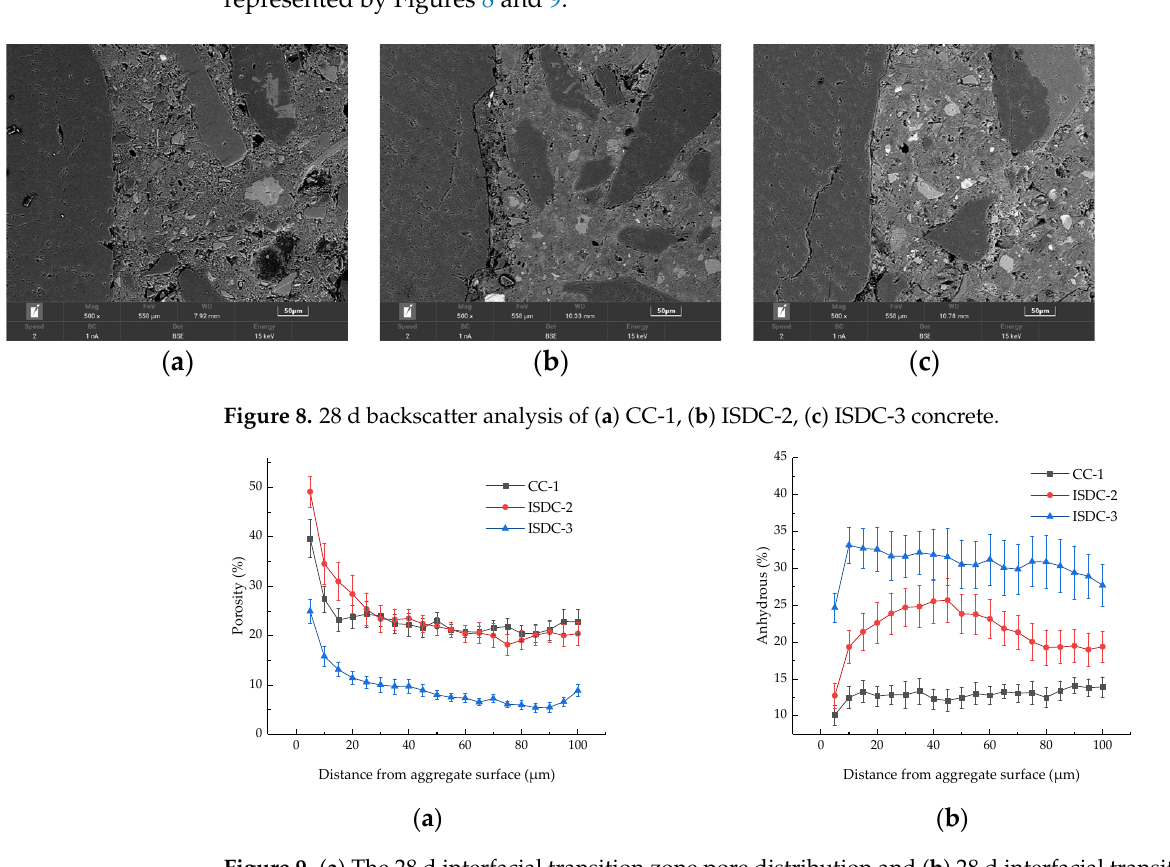
Figure 9. ( a ) The 28 d interfacial transition zone pore distribution and ( b ) 28 d interfacial transition zone non ‐ hydration distribution of ISD ‐ doped concrete.